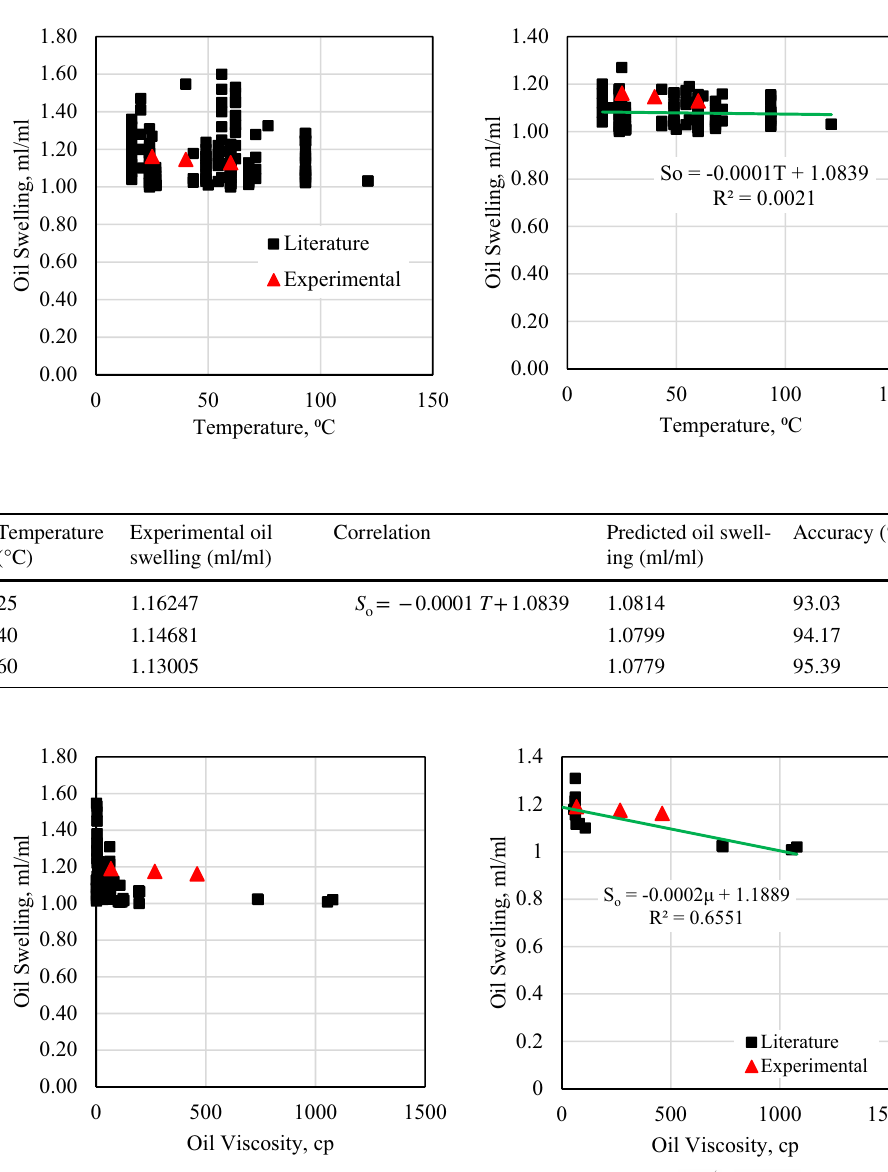
Fig. 8 Experimental and literature oil swelling values for different oil viscosity